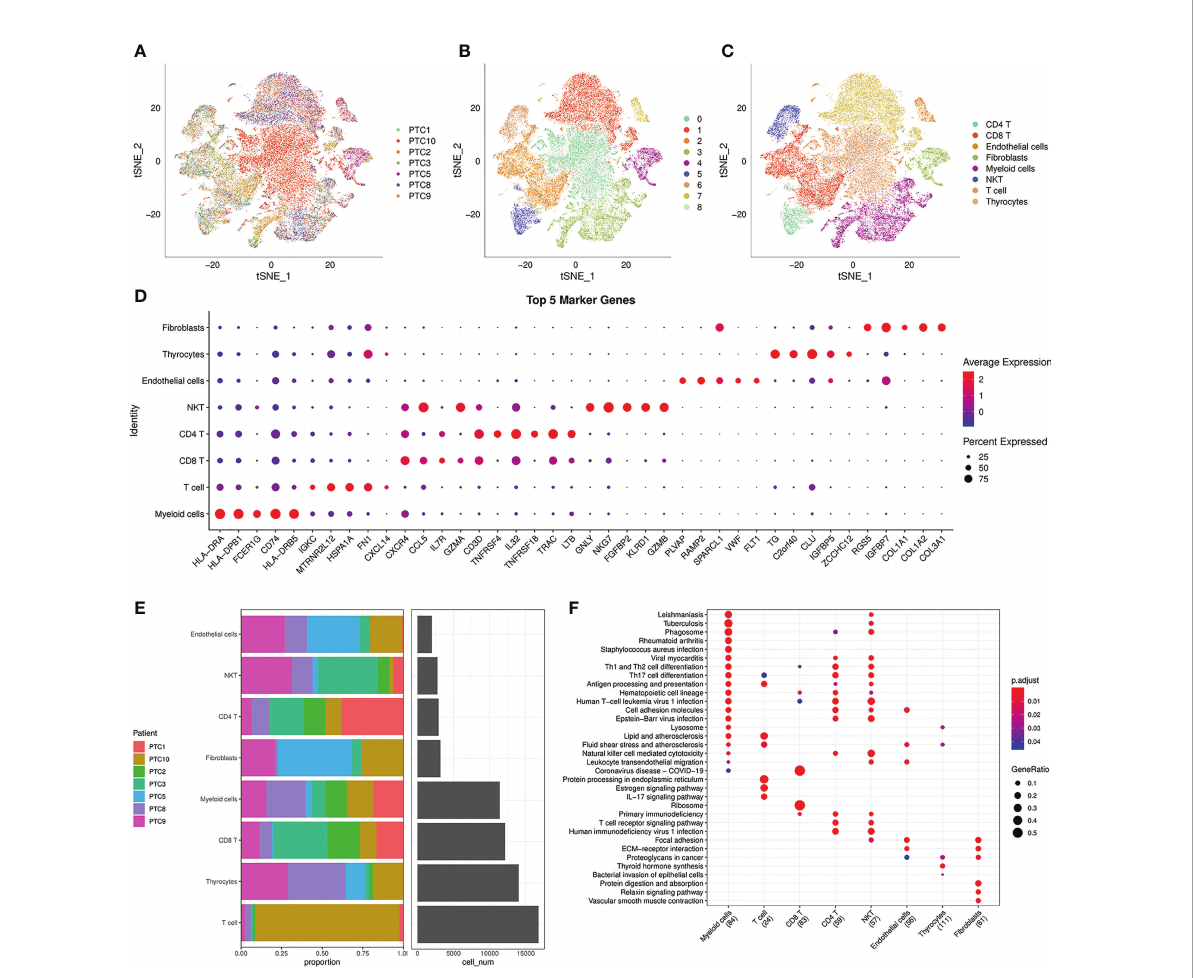
FIGURE 1 Analysis of 8 cell lineages. (A) t-SNE plot of fi ltered cells colored by samples. (B) t-SNE plot of fi ltered cells colored by clusters. (C) The cell lineages were identi fi ed by marker genes: CD4 T, CD8 T, endothelial cells, fi broblasts, myeloid cells, NK T, T cells, thyrocytes. (D) The expression of the fi rst 5 marker genes in each cell lineages. The size of the dot represents the fraction of cells in which the gene was detected. The color of the dot represents the average expression of the cells in each lineage. (E) The proportion of cells from 7 PTC samples in 8 cell lineages. (F) KEGG enrichment analysis of 8 cell